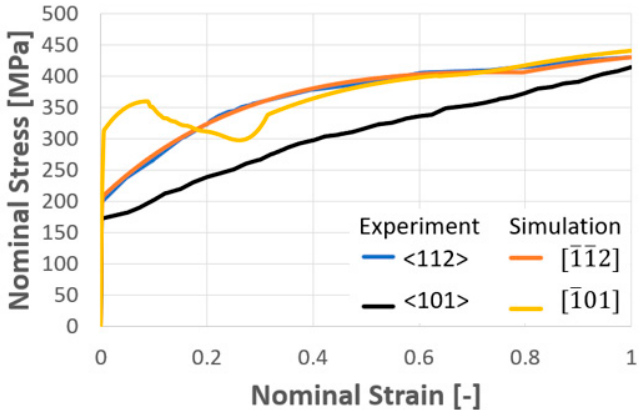
Figure 4. Nominal strain and nominal stress obtained by numerical simulation and experiment. The experimental results are reproduced from Ref. [46].